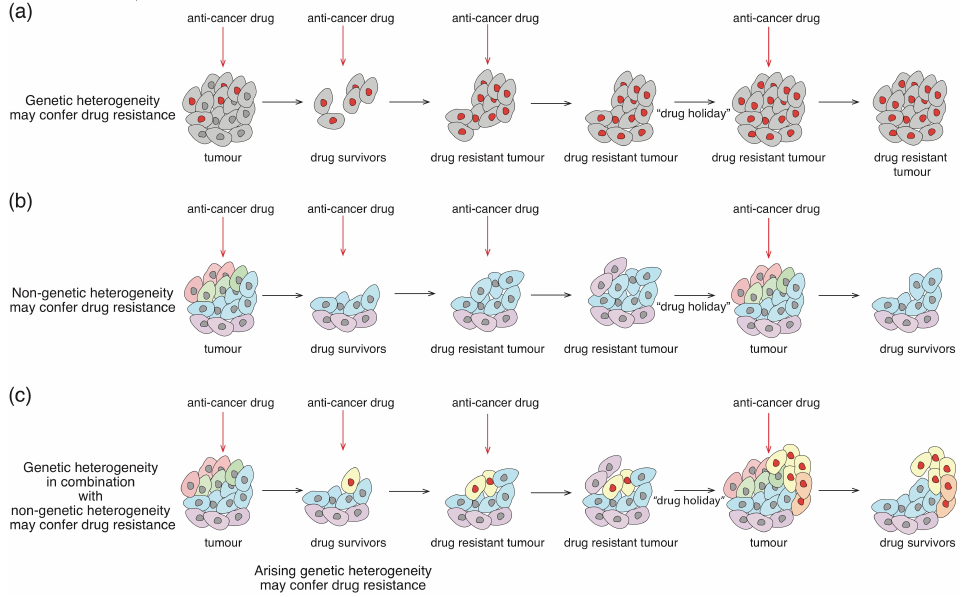
Figure 3. Models of cancer progression upon drug treatment. ( a ) A population of cancer cells may contain a pre-existing genetic mutation that confers resistance to an anti-cancer drug. This genetically encoded phenotype is further selected upon drug treatment, leading to outgrowth of a drug-resistant tumour. ( b ) A population of cancer cells may display extensive non-genetic heterogeneity resulting in multiple phenotypic (epi-)states co-existing within a population. Some of those (epi-)states may be resistant to drug treatment. Non-genetically encoded phenotypes can be further selected, leading to an outgrowth of a drug-resistant tumour. However, contrary to genetically encoded resistance, when drug treatment is discontinued, the population of cancer cells may re-establish its initial heterogeneity that displays drug sensitive phenotypes. ( c ) A population of cancer cells may contain drug resistant phenotypes driven by both genetic and non-genetic mechanisms. Such resistant phenotypes are selected upon drug treatment, leading to the generation of drug-resistant tumours. Each genotype may produce a variety of phenotypic (epi-)states. The colour of the nuclei depicts a defined genotype; the colour of the cytoplasm shows distinct phenotypes that may result from genetic and non-genetic